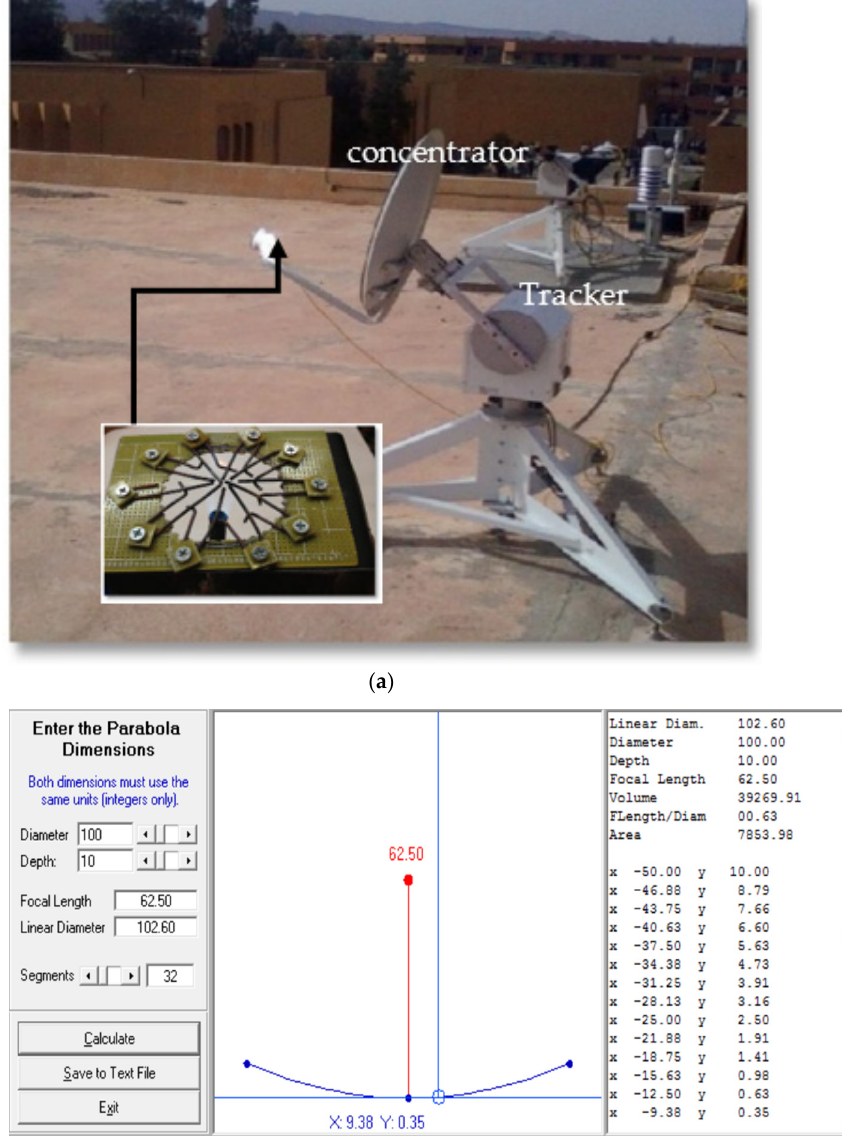
Figure 6. ( a ): Concentrator. ( b ): Concentrator characteristics.